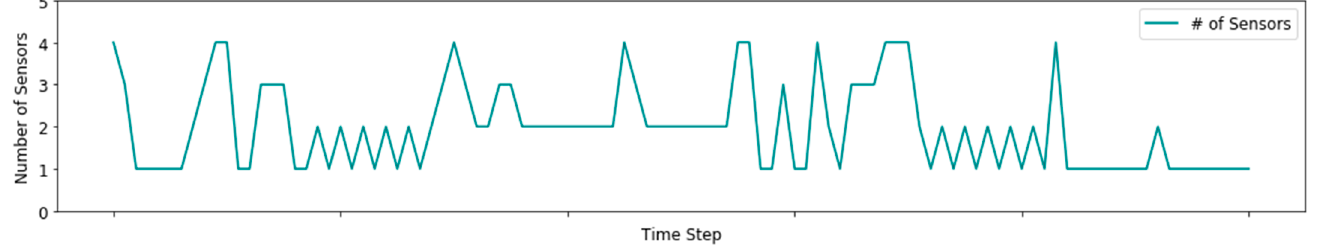
Figure 9. The number of sensors activated throughout the simulation using the greedy policy. Table 3. Percent of epochs during which each sensor was activated throughout the simulation. Sensor Usage